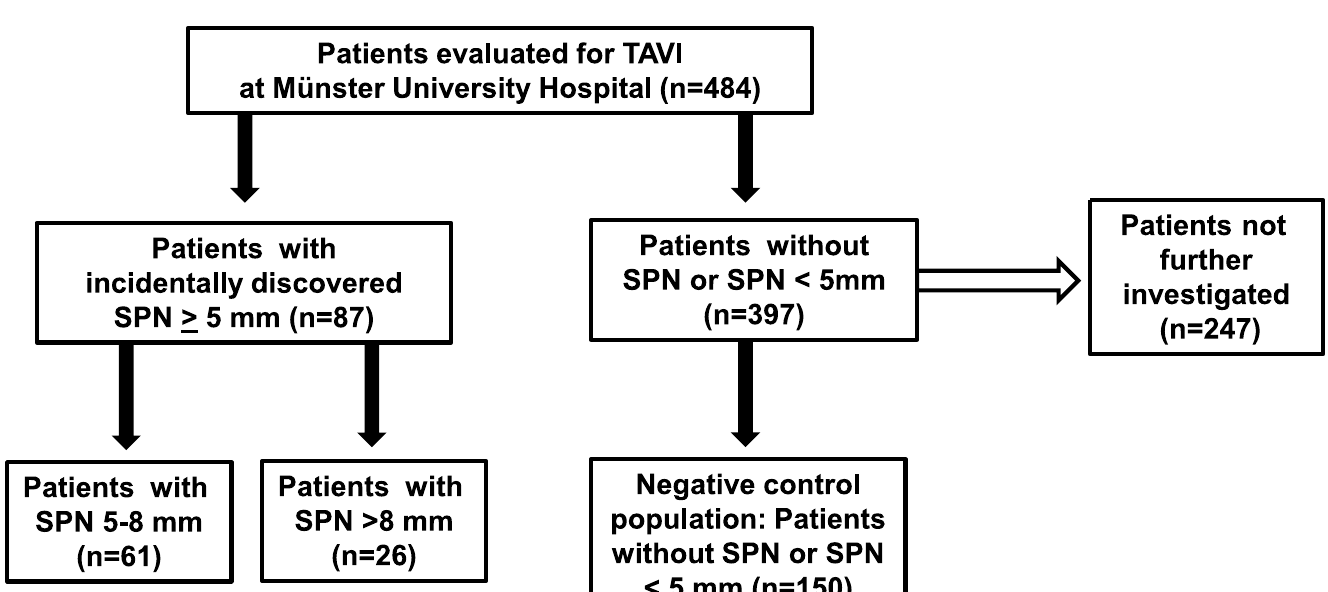
Fig 2. Study collective and tested clinical subgroups. The flow diagram demonstrates the selection of the tested subgroups ( * control group includes both patients without detected SPN and those patients with SPN <